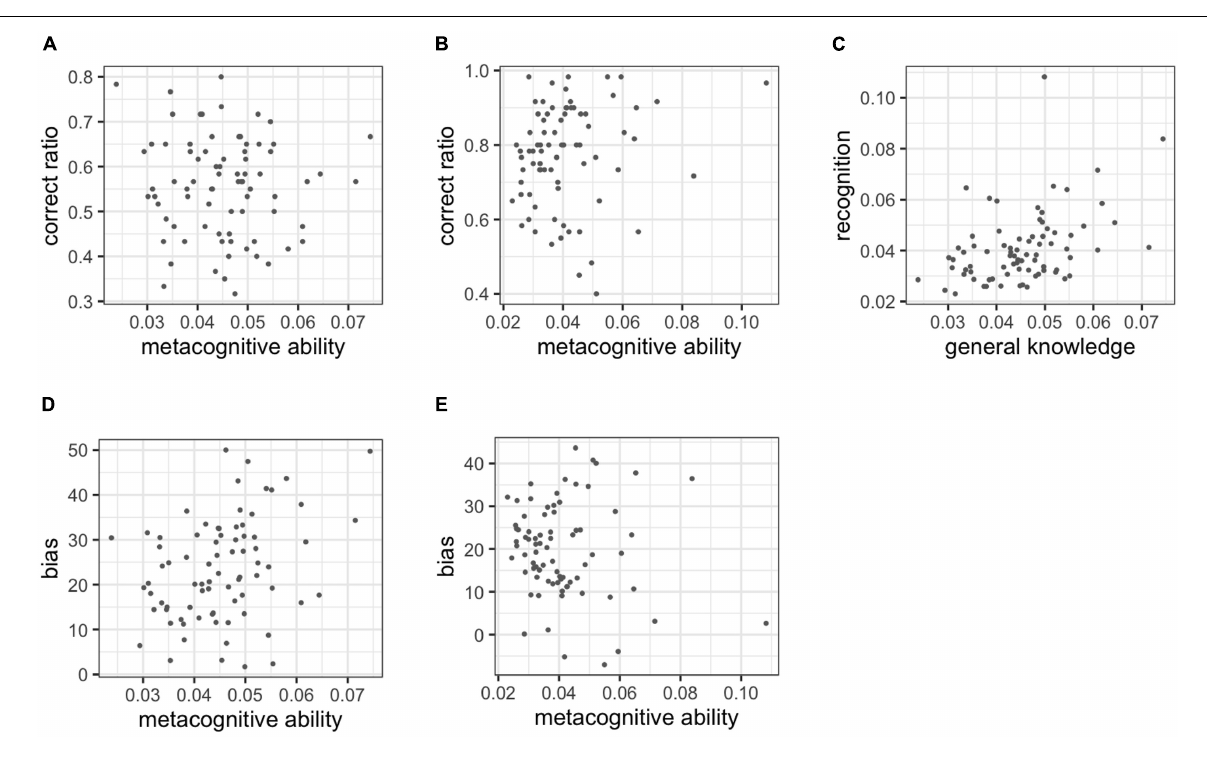
FIGURE 5 | (A) Correlations between the correct ratio and metacognitive ability in the general knowledge task, (B) correlation between the correct ratio and metacognitive ability in the recognition task, (C) correlation with metacognitive ability between tasks, (D) correlations between metacognitive ability and bias in the general knowledge task, (E) correlations between metacognitive ability and bias in the recognition